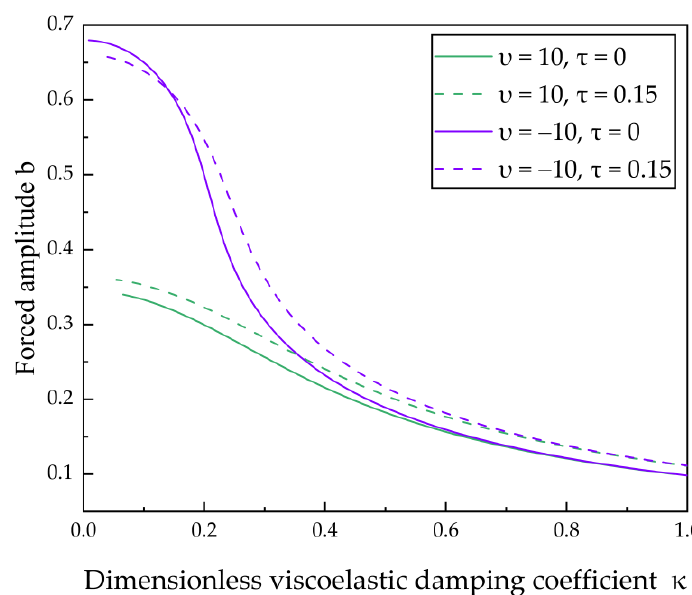
Figure 4. Forced amplitude versus viscoelastic damping coefficient.